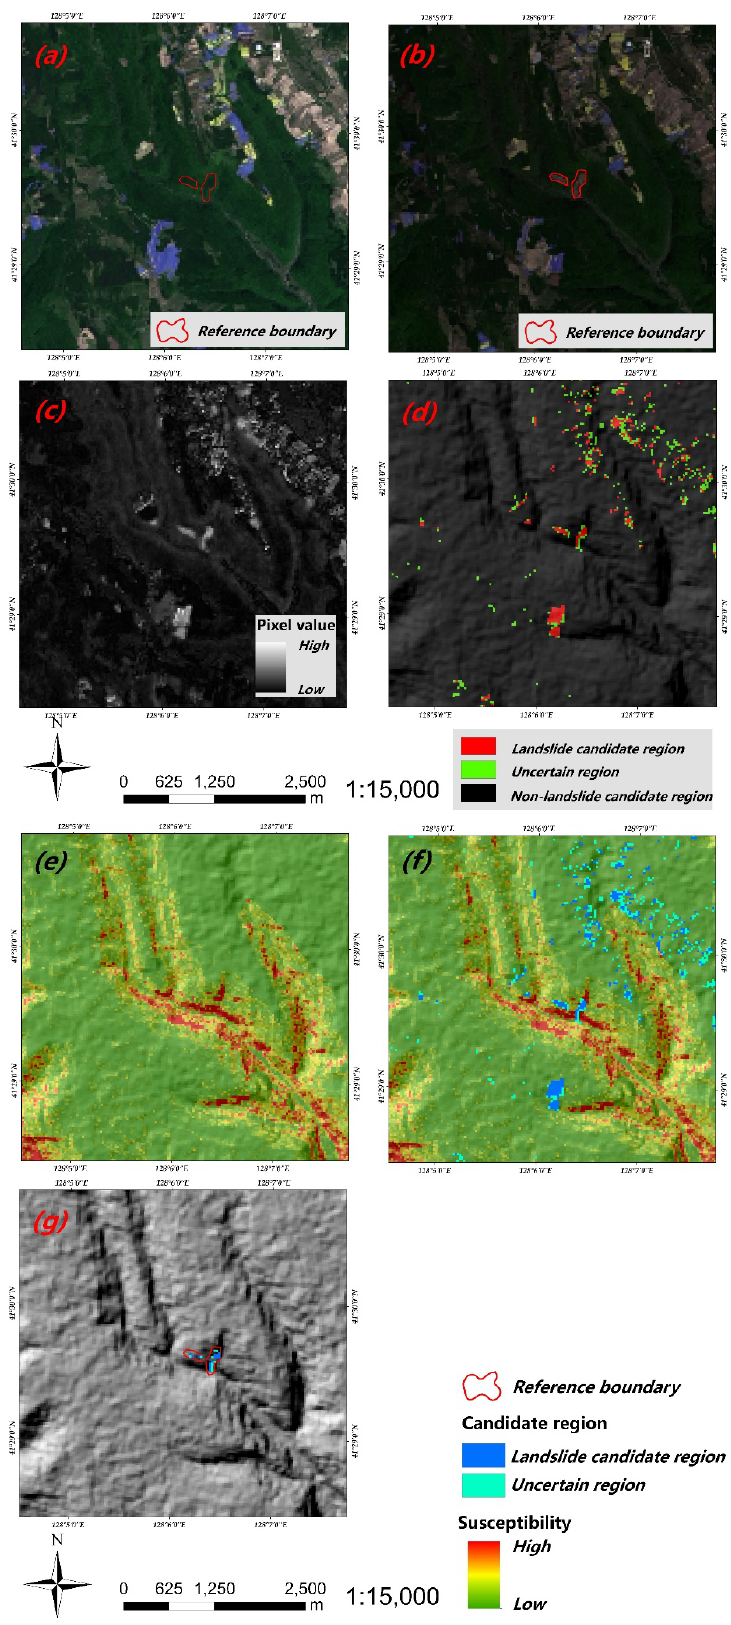
Figure 13. Landslide identification results in sub-area B. ( a ) Pre-event images; ( b ) post-event images; ( c ) difference image; ( d ) thresholding results; ( e ) susceptibility results; ( f ) overlapping; ( g ) final results.